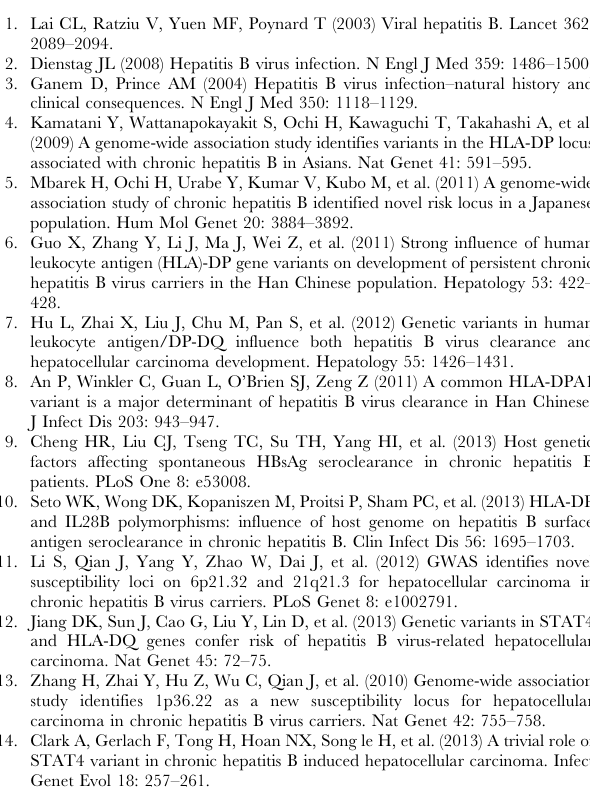
Figure S3 Forest plot for association of HLA-DQ rs2856718 with HCC development. Table S1 Information of primers used in this study. Table S2 Association of HLA-DP/DQ and STAT4 poly- morphisms with clinical indicators. Table S3 Clinical characteristics of the enrolled studies in the meta-analysis. Table S4 Quality assessment for all included studies using the Newcastle-Ottawa